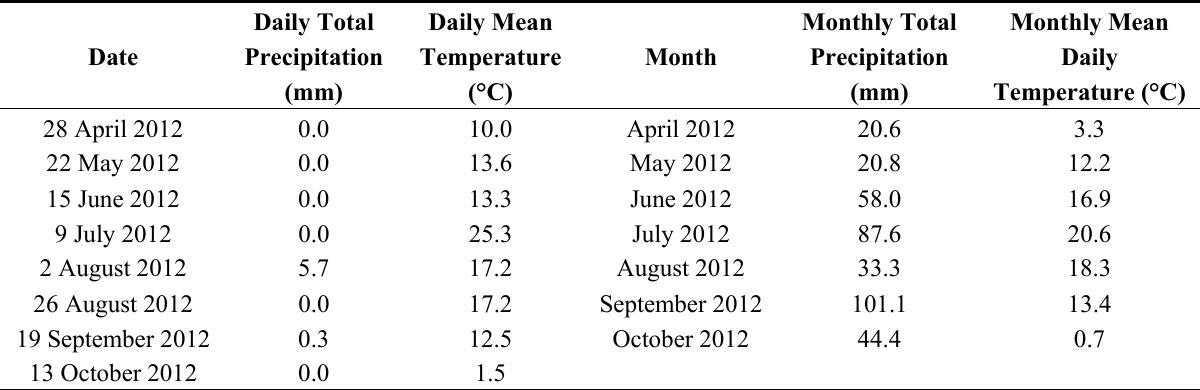
Figure 6. Landsat scenes used to validate the Peace-Athabasca Delta radar-derived surface water maps. The panel on the left is a Landsat 7 ETM+ scene from 28 April 2012, and the right panel is a Landsat 7 ETM+ scene from 22 May 2012. The red box clearly shows that large portions of the lake were still frozen on 28 April 2012, but had become open water by 22 May 2012. Table 2. Mildred Lake, Alberta, weather station data. Mean daily temperature (°C) and total precipitation (mm) for the dates of the RADARSAT surface water maps, and monthly average daily mean temperature (°C) and monthly total precipitation